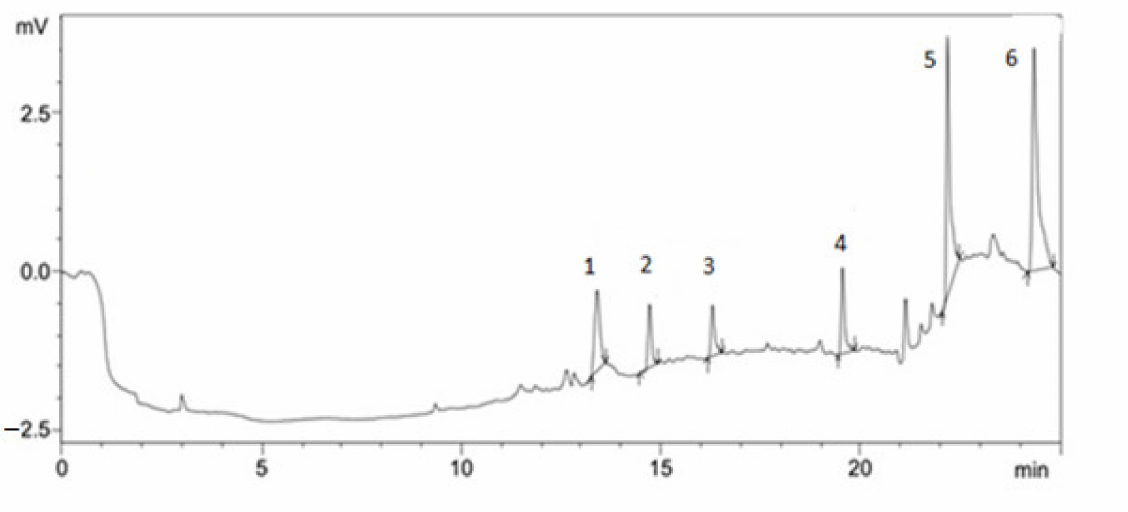
Figure 4. BAS isolated from Dactylorhiza maculata extract samples by HPLC: (1) 3,3 (cid:48) ,4 (cid:48) ,5,5 (cid:48) ,7-hexahydroxyflavonone; (2) 3,3 (cid:48) ,4 (cid:48) ,5,5 (cid:48) ,7-hexahydroxyflavonone-3- O -glycoside; (3) gallic acid; (4) ferulic acid; (5) rutin; (6) quercetin.